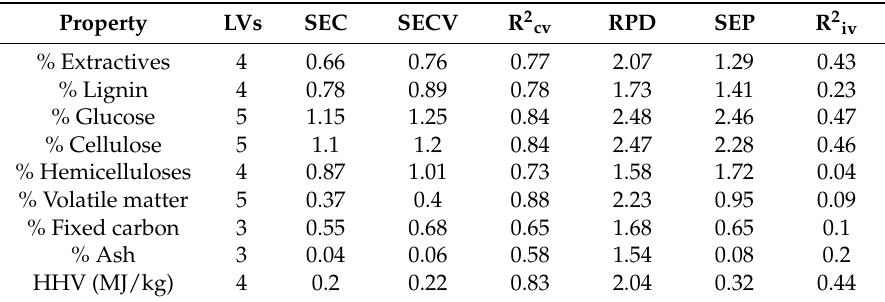
Table 3. Calibration and prediction statistics of NIR-based Partial Least Squares regression (PLS) models for chemistry and